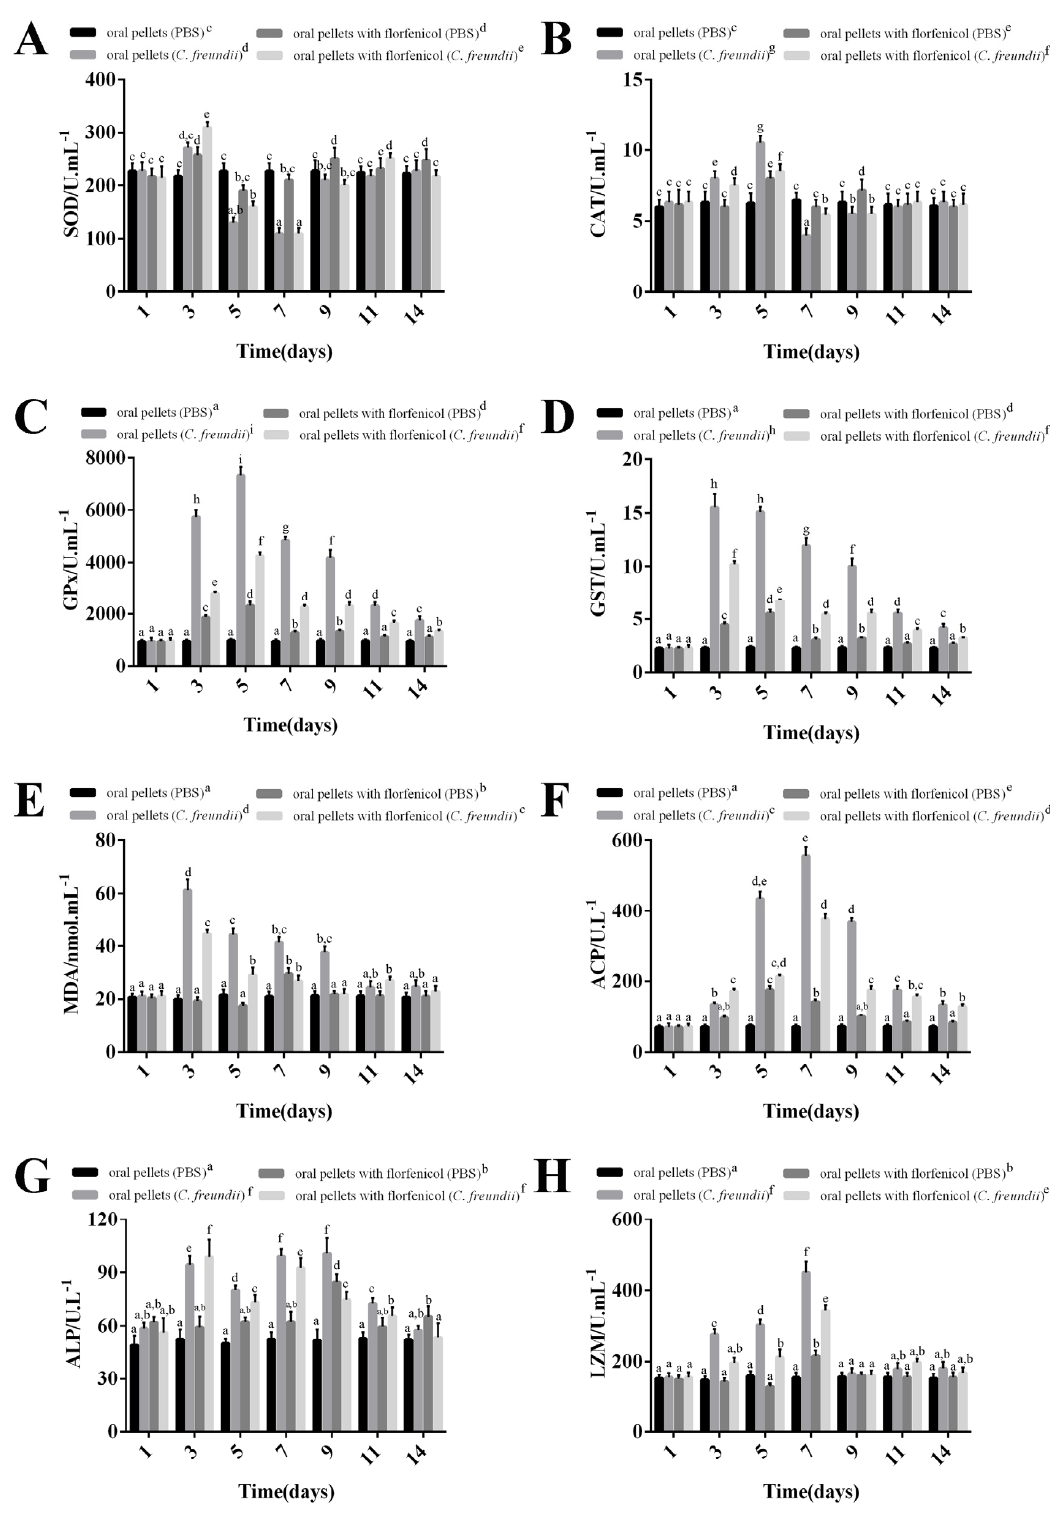
Figure 8. Changes in non-specific immune parameters of M. rosenbergii hemolymph at 1-, 3-, 5-, 7-, 9-, 11-, and 14 - days after C. freundii infection. ( A ) SOD, ( B ) CAT, ( C ) GPx, ( D ) GST, ( E ) MDA, ( F ) ACP, ( G ) ALP, and ( H ) LZM activities. Data are presented as mean ± standard error of the mean (SEM) ( n = 3); different graphemes (a, b, c, d, e, f, g, h and i) indicate significant difference values of non-specific immune parameters at p < 0.05.